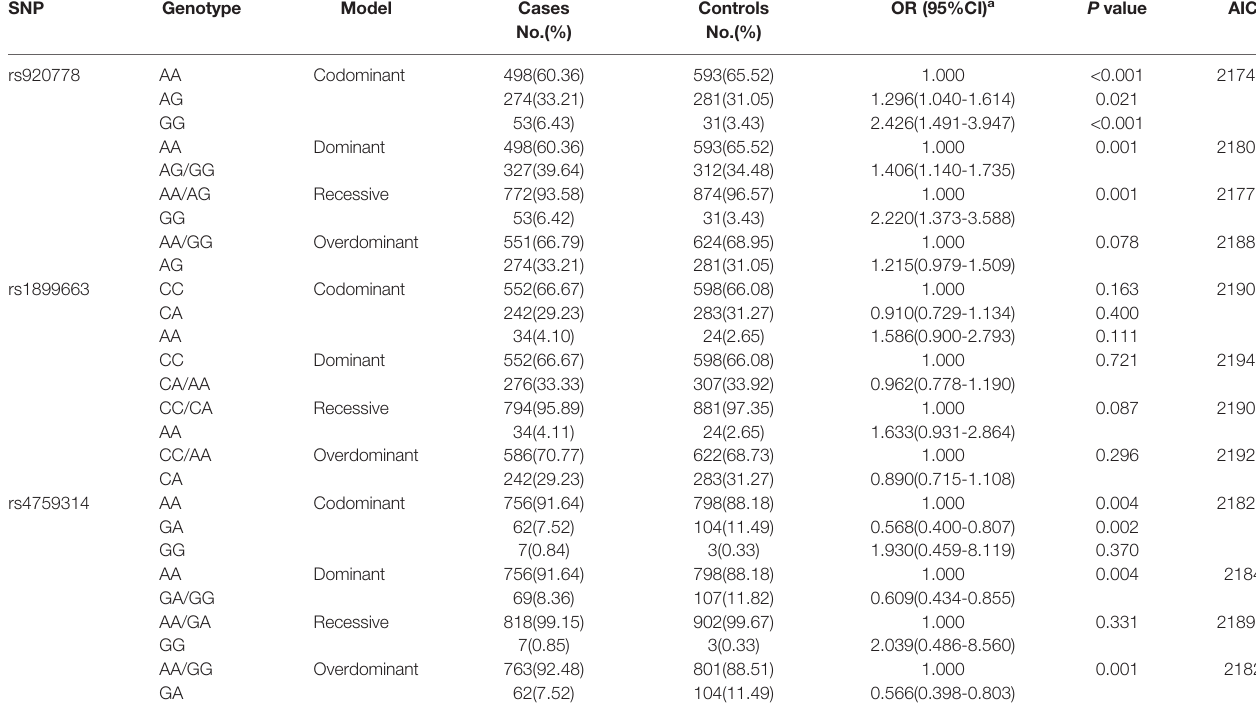
TABLE 3 | Association between HOTAIR SNPs and breast cancer risk.